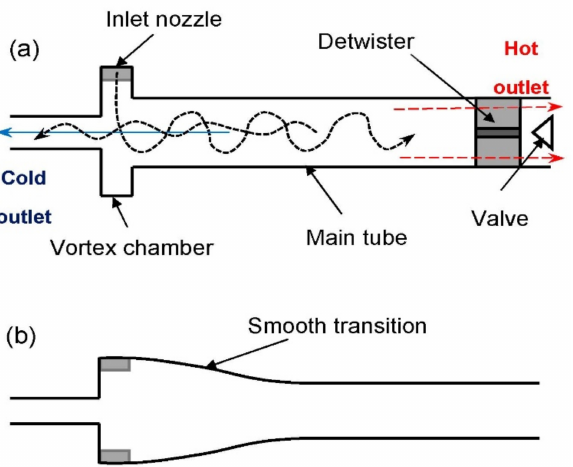
Figure 1. ( a ) General vortex tube schematic. Dotted curves show possible trajectories of fluid particles. Dashed lines indicate axial flow toward the hot exit (red) and cold outlet (blue). ( b ) Vortex tube configuration with smooth transition studied in this